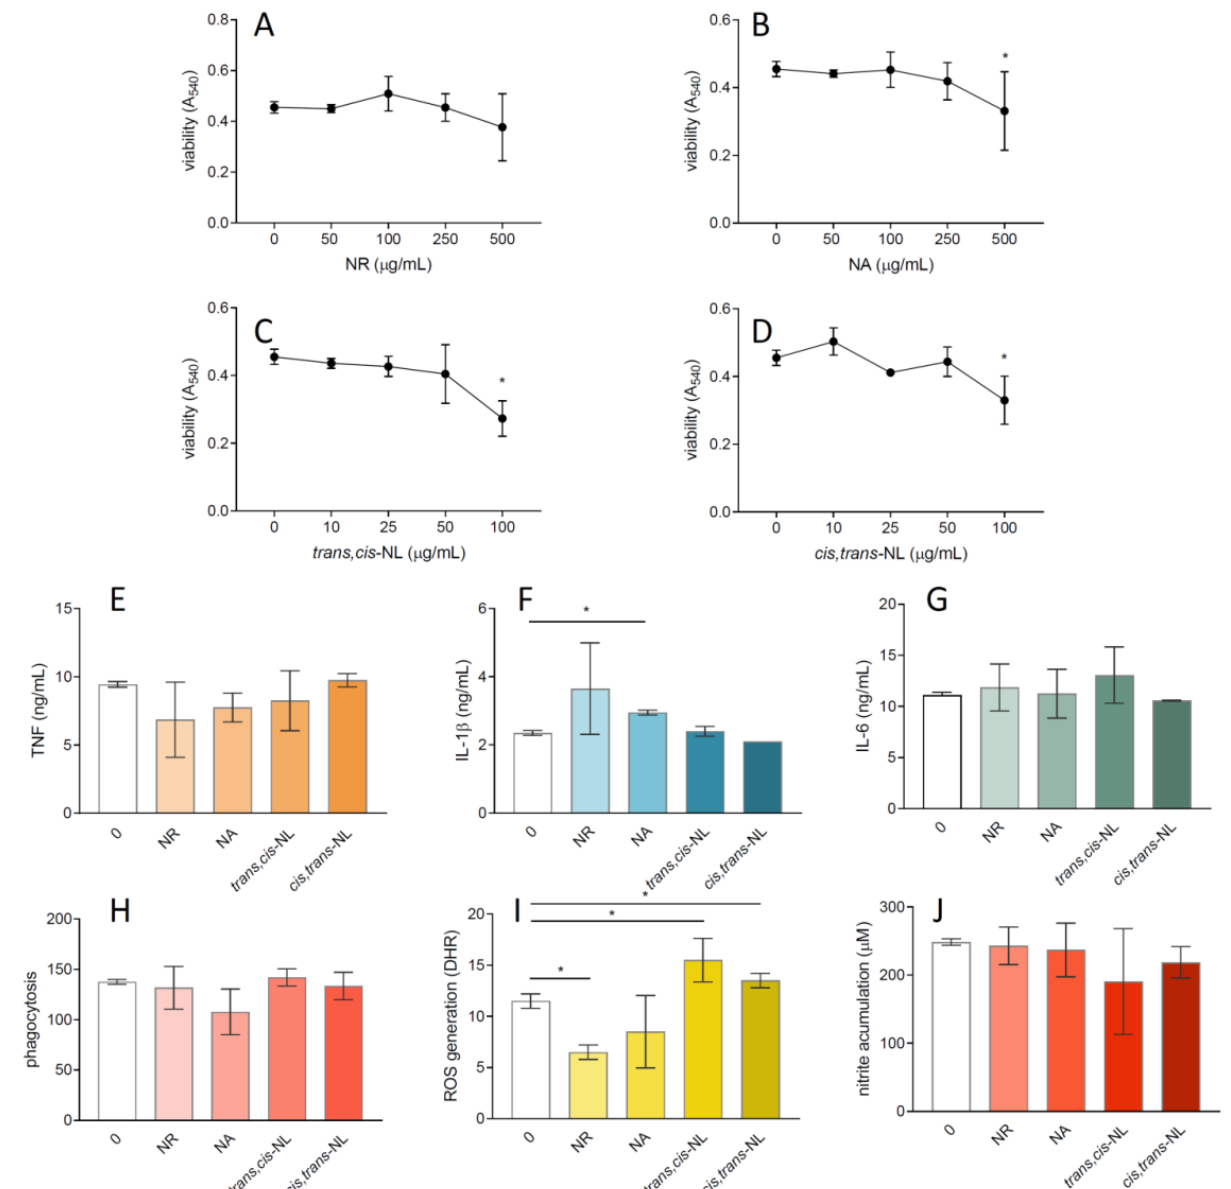
Figure 5. Effects of N. rtanjensis and N. argolica subsp. argolica methanol extracts and nepetalactones ( cis,trans -NL and trans,cis -NL) on macrophages. Macrophages were stimulated with LPS and treated with various concentrations of extracts and nepetalactones for 24 h. Subsequently, cell viability was determined by CV test ( A – D ), while productions of cytokines ( E – G ) and nitrite ( J ) were measured in the culture supernatants. Phagocytosis ( H ) and ROS levels ( I ) in the absence (0) or presence of extracts or nepetalactones (250 or 50 µ g mL − 1 ) were determined by cytofluorimetry. Data are presented as mean + SD from repeated experiments. * p < 0.05 is statistically